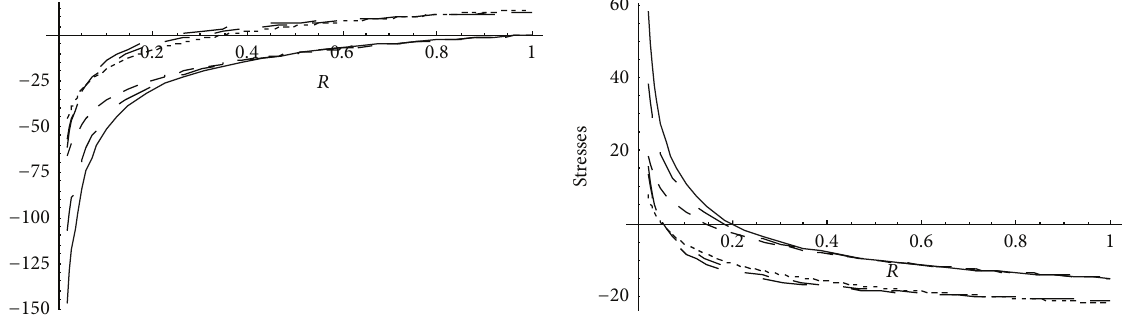
Figure 9: Homogeneous transitional stresses for a thick-walled circular cylinder under internal ( 𝑃 1 = 10 ) and external pressure ( 𝑃 2 = 0 and 15).